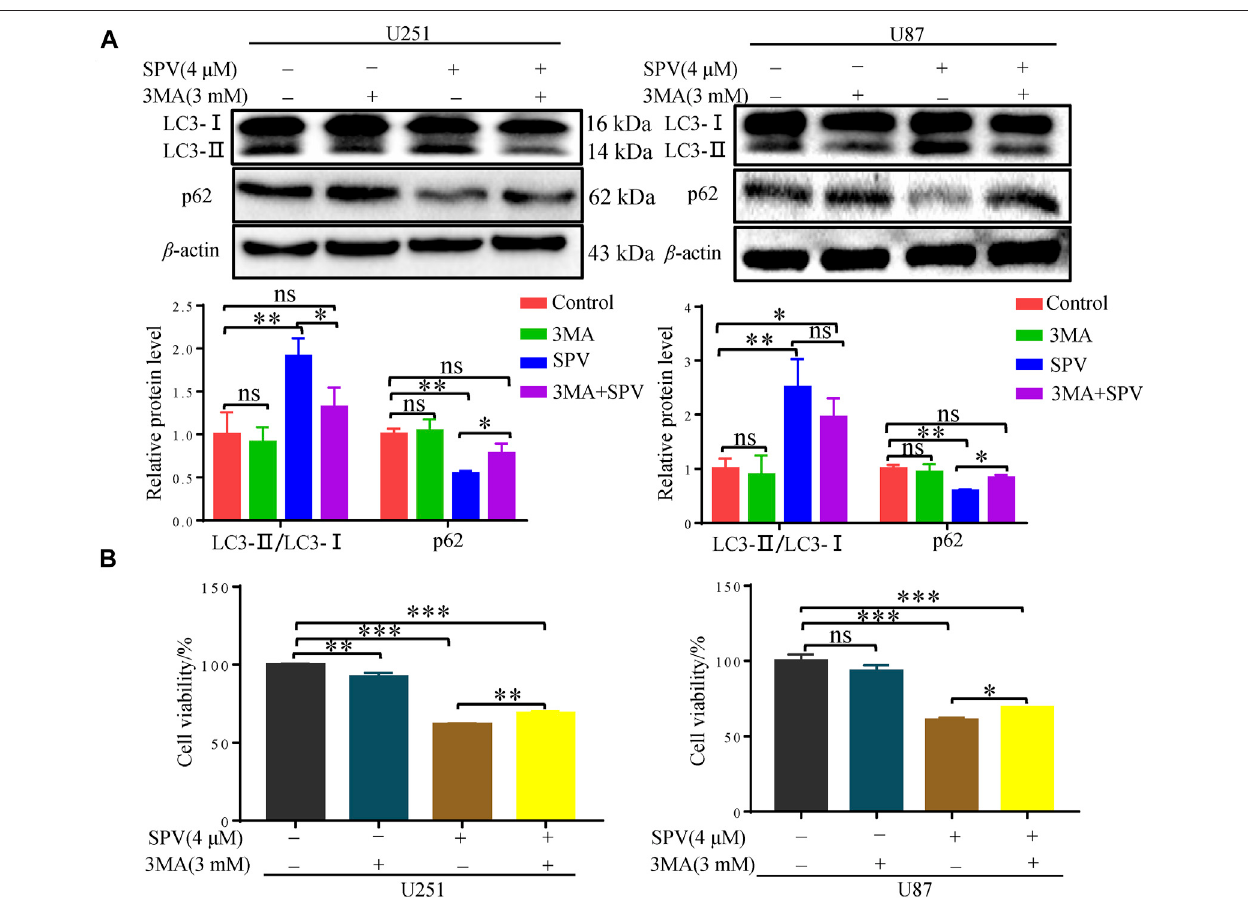
Figure6| Sempervirineinducesautophagicdeathofgliomacells. (A) 3-MA(3 mM)wasaddedtocells2 hbeforesempervirinetreatment.After48 h,Westernblottingfor autophagy-associatedproteinLC3andp62. (B) Cellviabilitywasdetermined.3-MAwasaddedtocells2 hbeforesempervirinetreatment.Then,cellstreatedwithsempervirine for 48 h. Cell viability was determined by MTT. Data are presented as the Mean ± SD ( n (cid:2) 3). * p < 0.05, ** p < 0.001 and *** p < 0.001 compared with the control group.